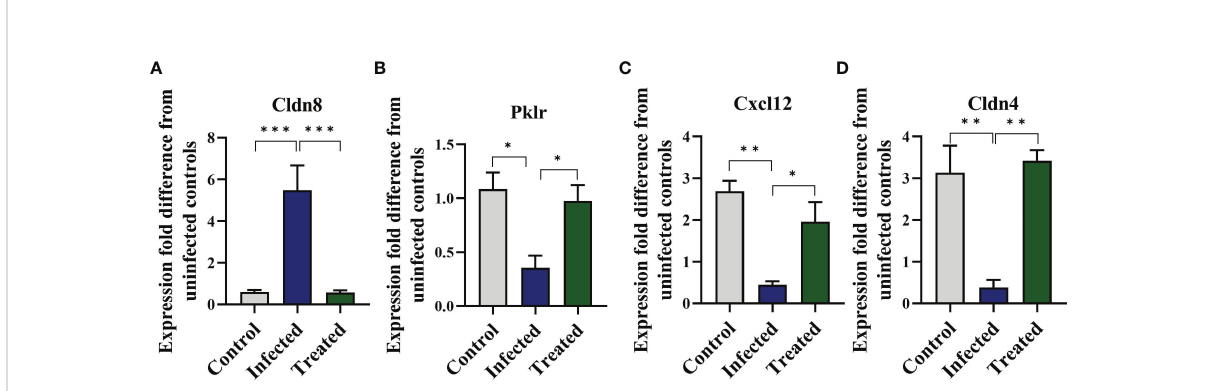
FIGURE 9 Mebendazole (MBZ) ameliorates abnormal gene expressions induced by the protoscoleces of Echinococcus granulosus infection in the colon of mice. qPCR was performed to verify indicated mRNA levels. (A) mRNA levels of Cldn8. (B) mRNA levels of Pklr. (C) mRNA levels of Cxcl12. (D) mRNA levels of Cldn4. * P < 0.05, ** P < 0.01, *** P <